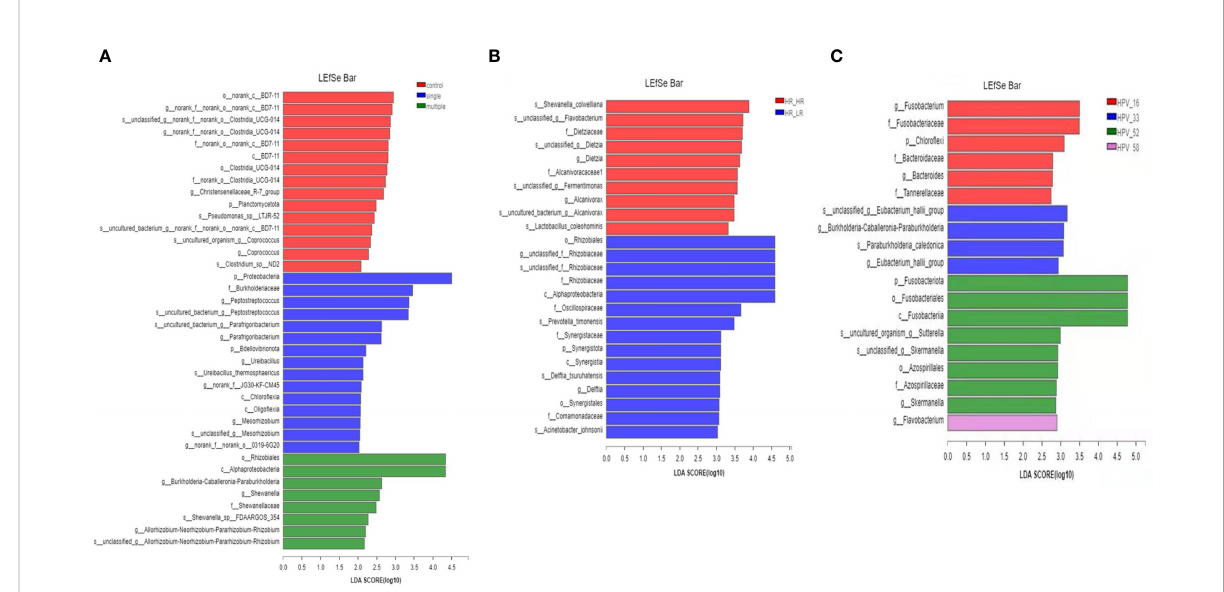
FIGURE 5 Taxonomic biomarkers. (A) The linear discriminant analysis (LDA) effect size (LEfSe) analysis among control, single-infection, and multiple-infection groups. (B) The linear discriminant analysis (LDA) effect size (LEfSe) analysis between HR-HPV, HR-HPV and LR-HPV, and HR-HPV